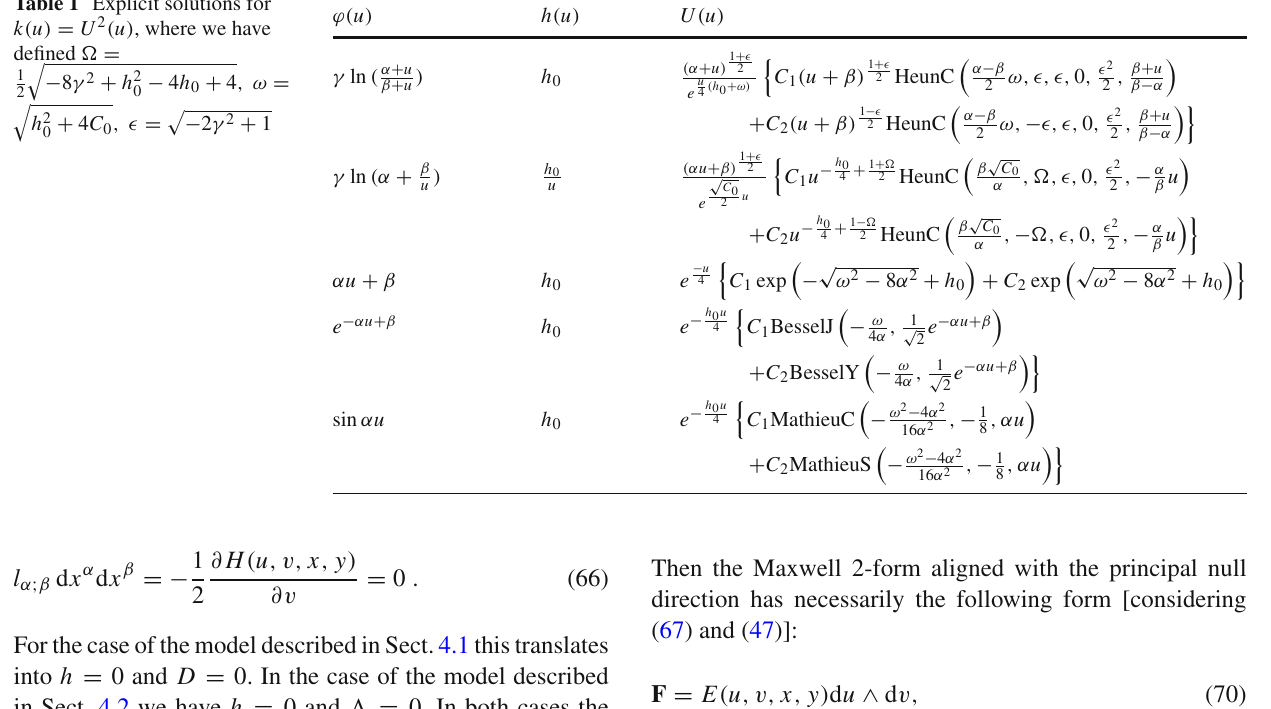
Table 1 Explicit solutions for k ( u ) = U 2 ( u ) , where we have (cid:24) defined (cid:19) = − 8 γ 2 + h 2 1 2